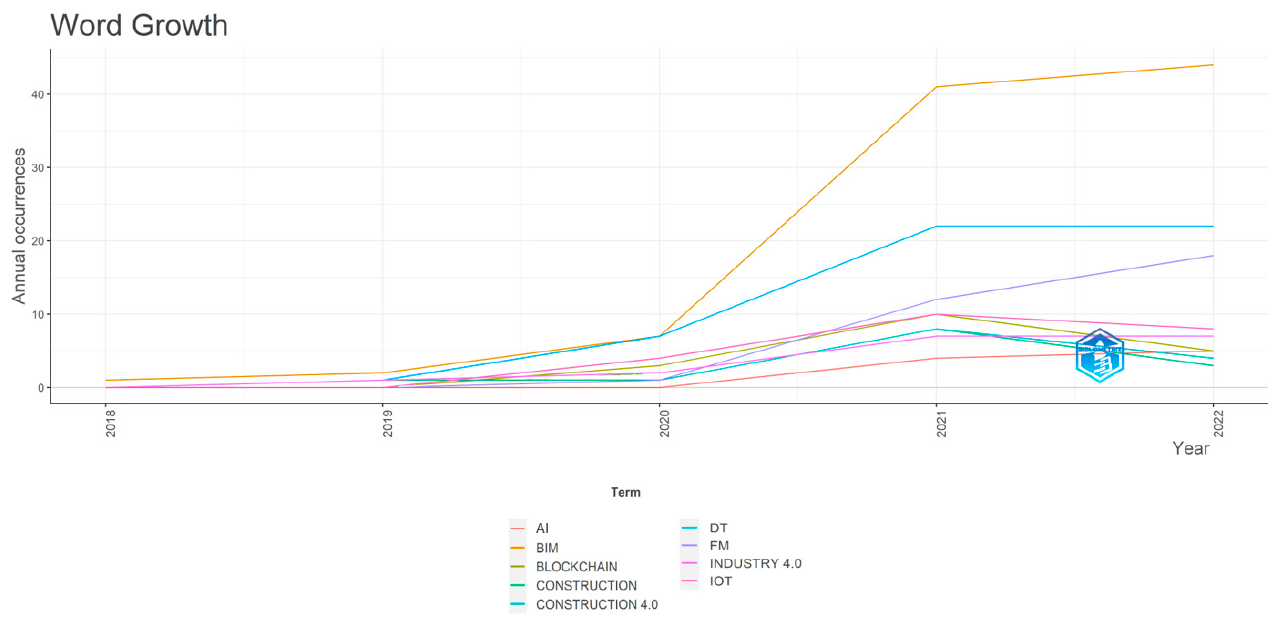
Figure 5. Words’ dynamics through time performed with Biblioshiny version 4.0.